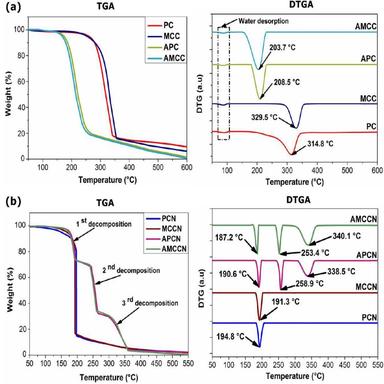
TGA and DTGA thermograms of (a) functionalized samples and their starting precursors; (b) nitrated samples.